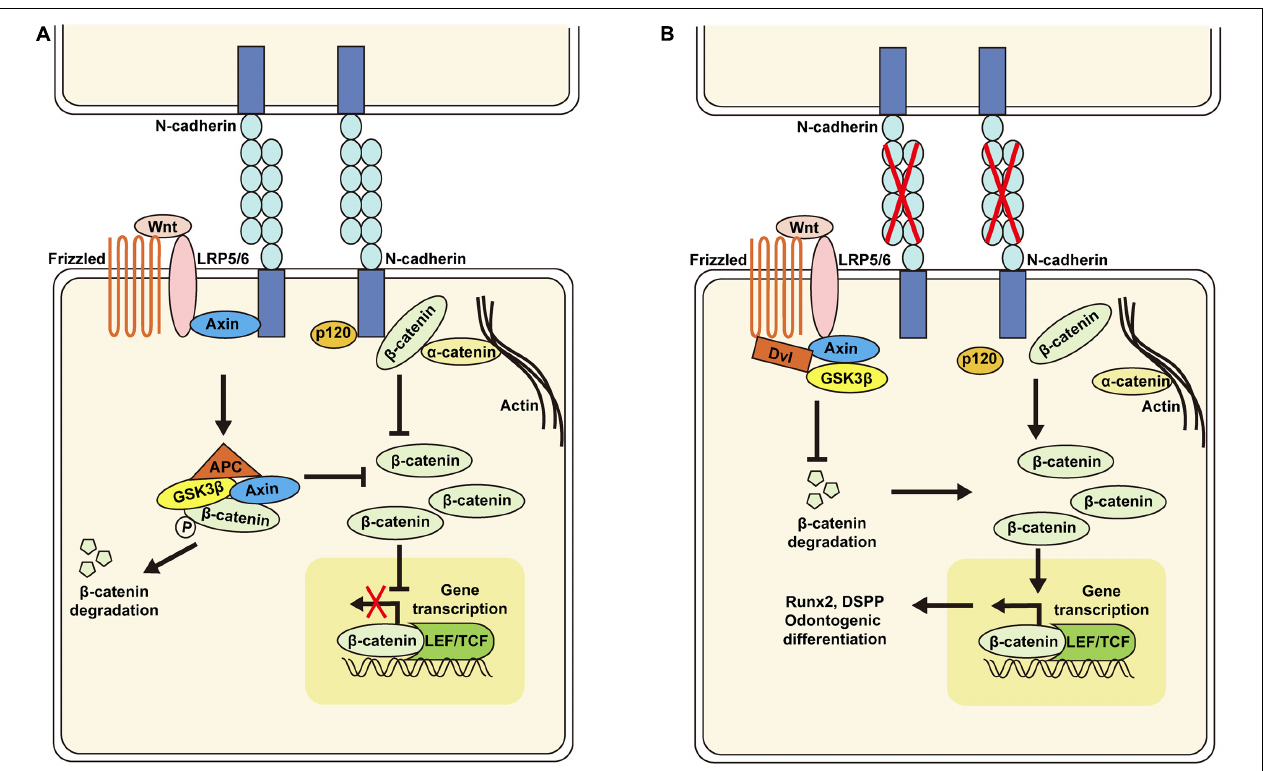
FIGURE 7 | Schematic of the proposed model for N-cadherin/ β -catenin signaling in the regulation of odontogenic differentiation of dental pulp stem cells (DPSCs). N-cadherin can sequester β -catenin at the cell–cell adhesion site and associate with the Wnt co-receptor LRP5/6 and Axin to inhibit β -catenin signaling (A) . N-cadherin downregulation can promote β -catenin release at the cell membrane and decrease interaction with LRP5/6, resulting in β -catenin signaling activation, Runx2 and DSPP upregulation, and odontogenic differentiation of DPSCs (B)